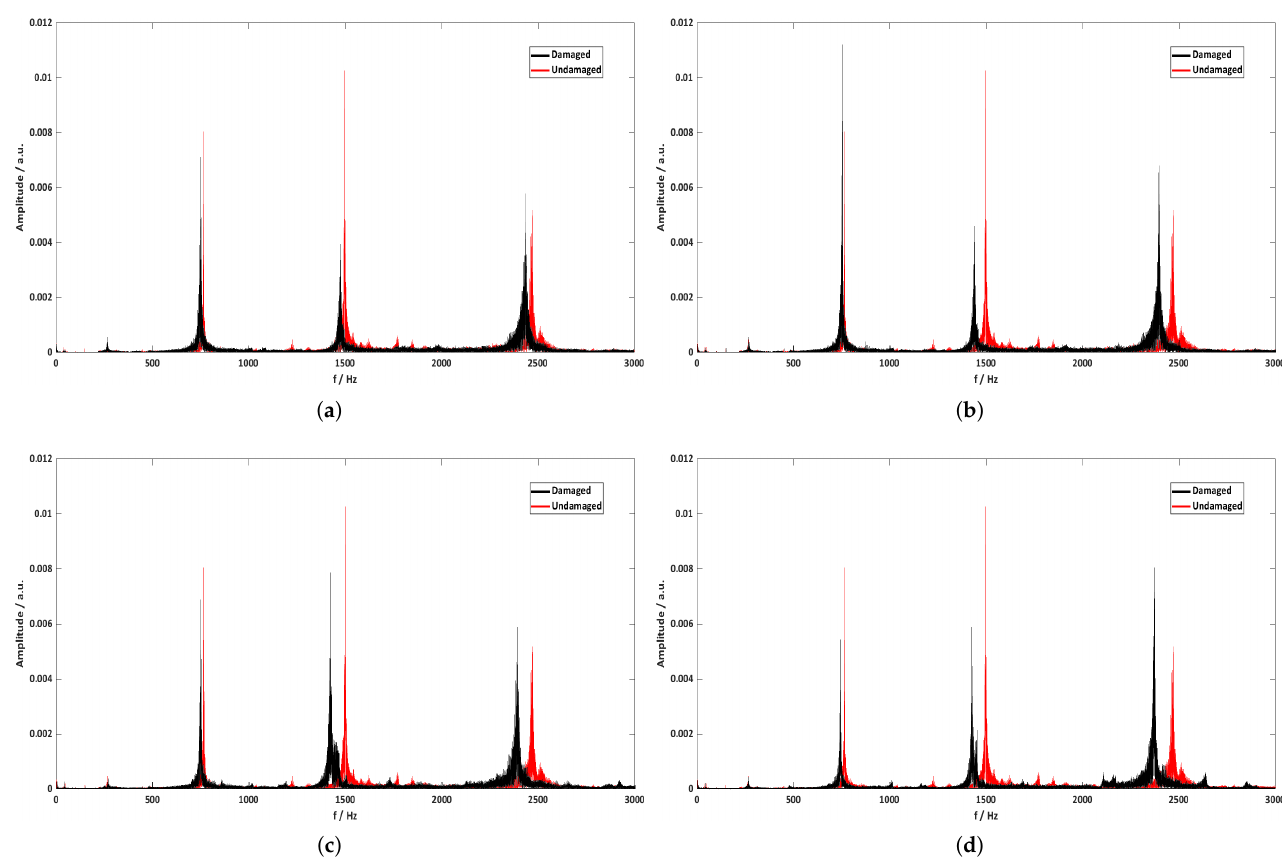
Figure 11. FFT spectrum results for each blade between the undamaged and the damaged state: ( a ) 1st, ( b ) 2nd, ( c ) 3rd, and ( d ) 4th. Table 6. Frequency comparison results between the undamaged and the damaged state of each rotating blade. Bending